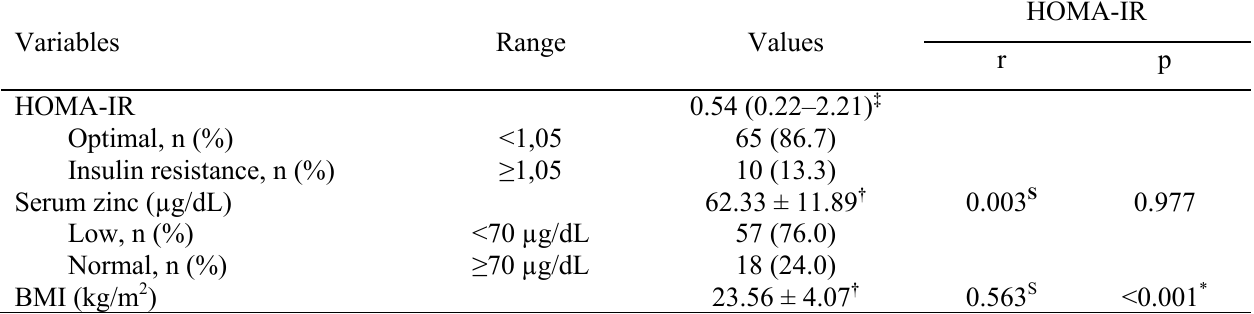
Table 3. Correlations between serum zinc and BMI with HOMA-IR Variables